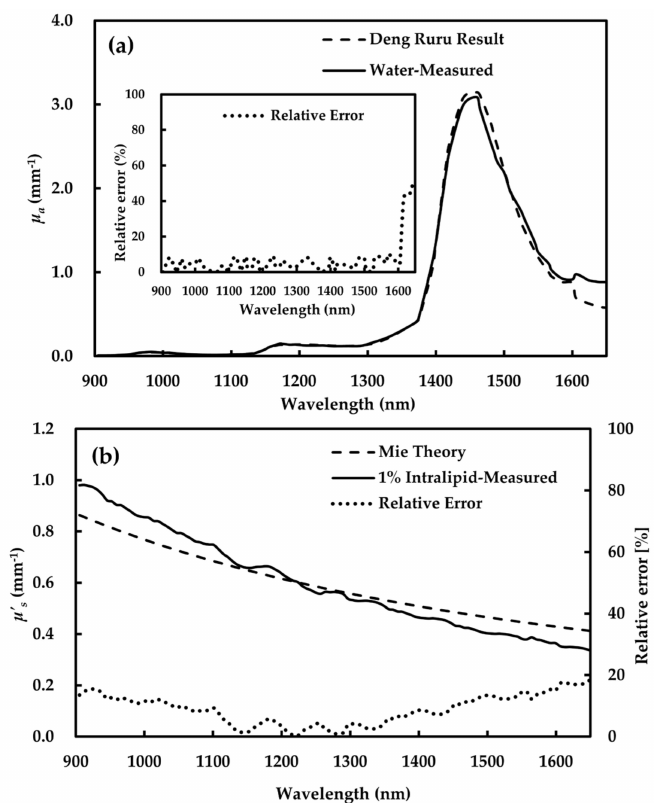
Figure 2. Absorption ( µ a ) estimation on water ( a ) and scattering ( µ (cid:48) s ) estimation on 1% Intralipid ( b